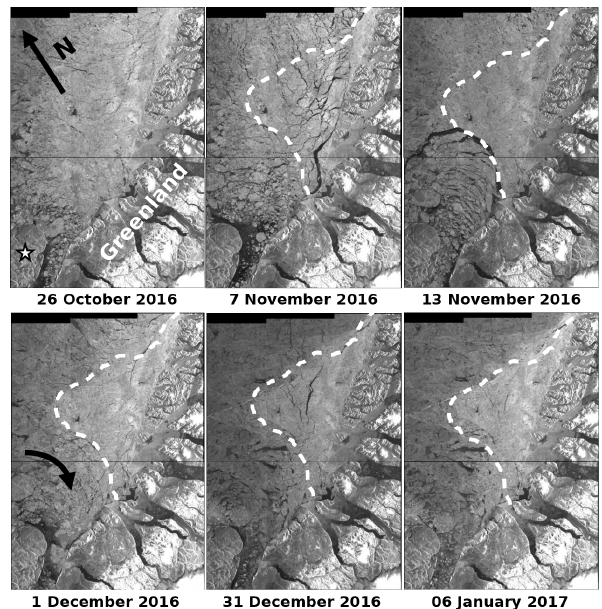
Figure 7. Sequence of Sentinel-1A/1B images for an area north of the Robeson Channel. The dotted curve marks an area of consoli- dated ice (still visible in the 26 October image). Ice cracked in this area on 7 November and an ice arch was formed on 13 November. The star in the middle panel of the top row marks Ellesmere Island. Ice floes that made their way to the Robeson Channel originate from the west (not north), following the path shown by the arrow in the 1 December